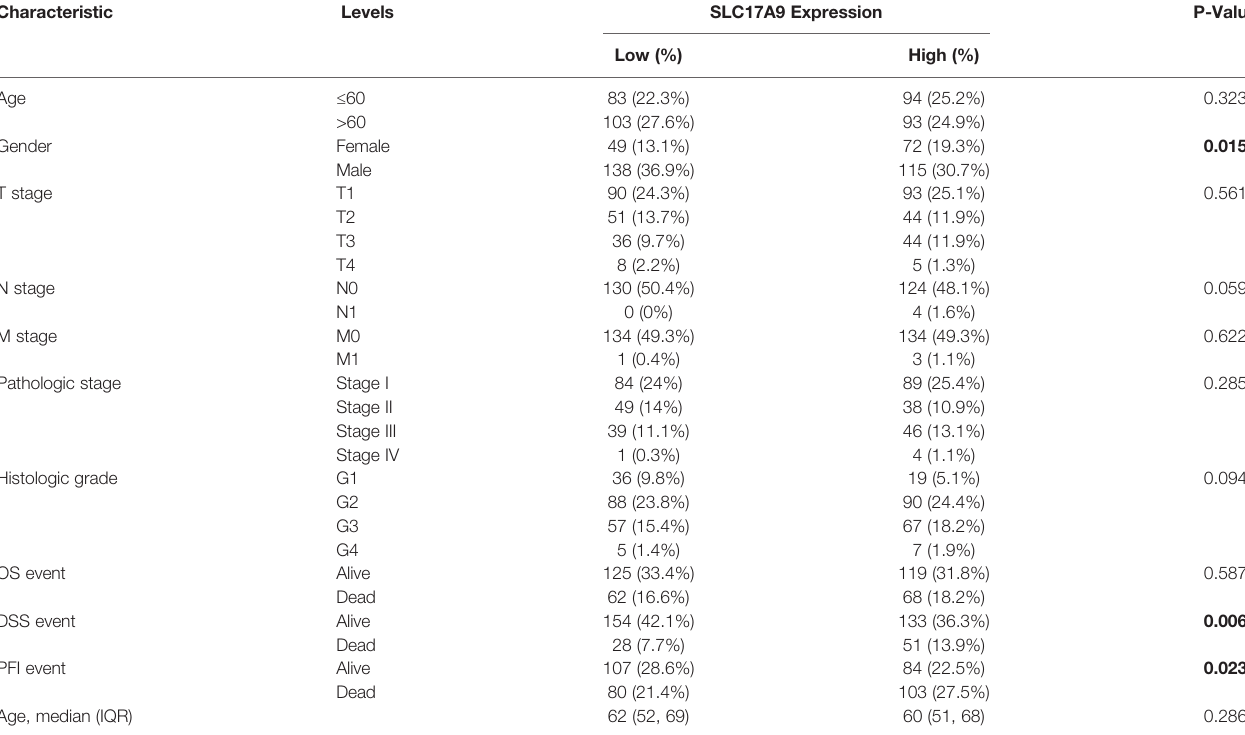
TABLE 2 | Correlation between SLC17A9 expressions and different clinicopathological characteristics in LIHC. Characteristic